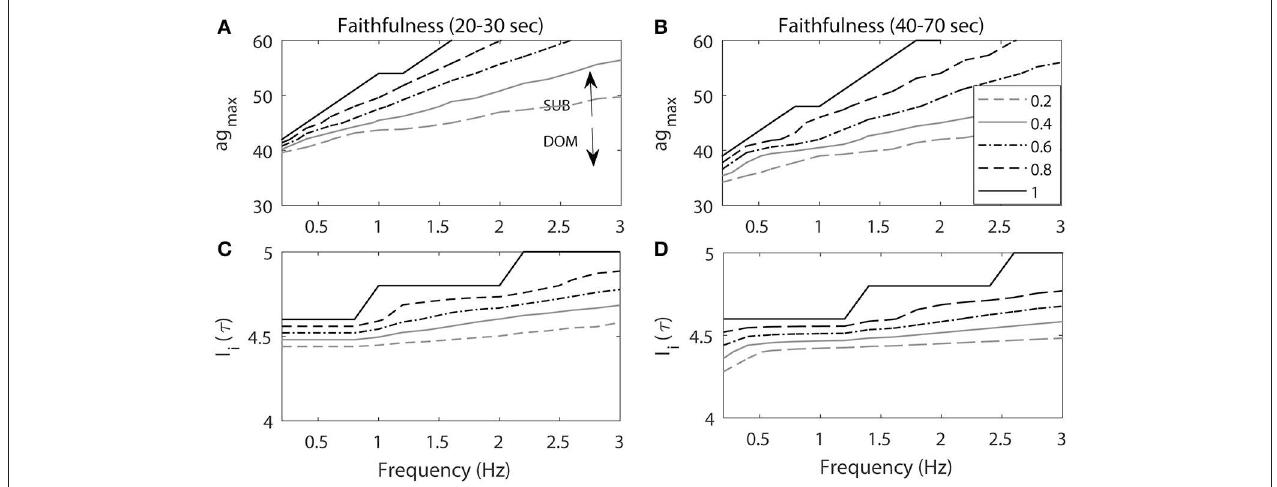
FIGURE 7 | The projection of contour level curves of Faithfulness onto the plane. Faithfulness of M-cell with the frequency and ag max (A,B) and amplitude of the stimulation input I i ( τ ) (C,D) . (A,C) Faithfulness during 20–30s period when the repeated stimulations delivered at 20s. ( B , D ) Faithfulness during 40–70s period. High ag max resembles the activity patterns for subordinate-like case (SUB) while low ag max resembles the activity patterns for dominant-like case (DOM). Different curves represent different values of